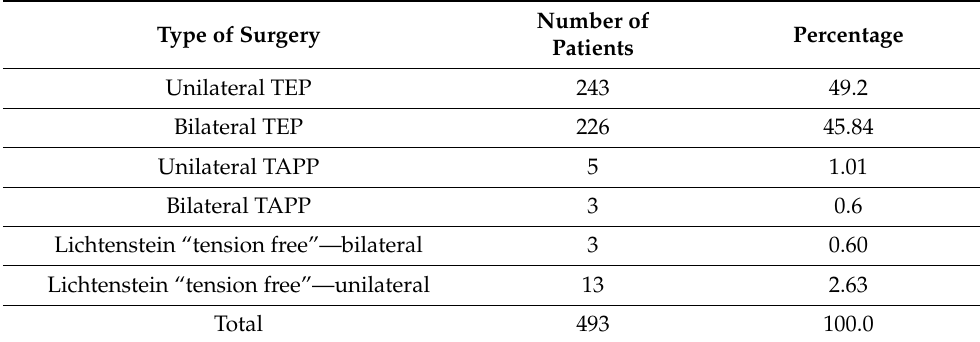
Table 1. Type of surgery and the number of